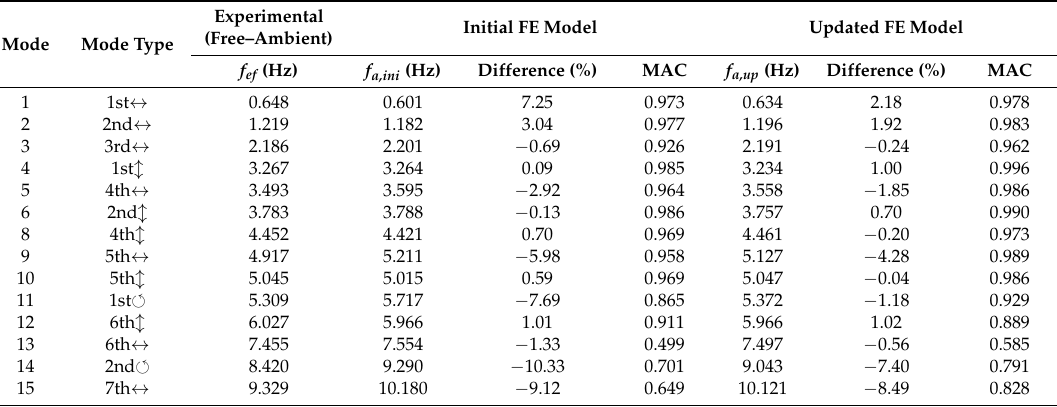
Table 4. The modal frequencies and MAC values from the experiment, the initial FE model, and the updated FE model.